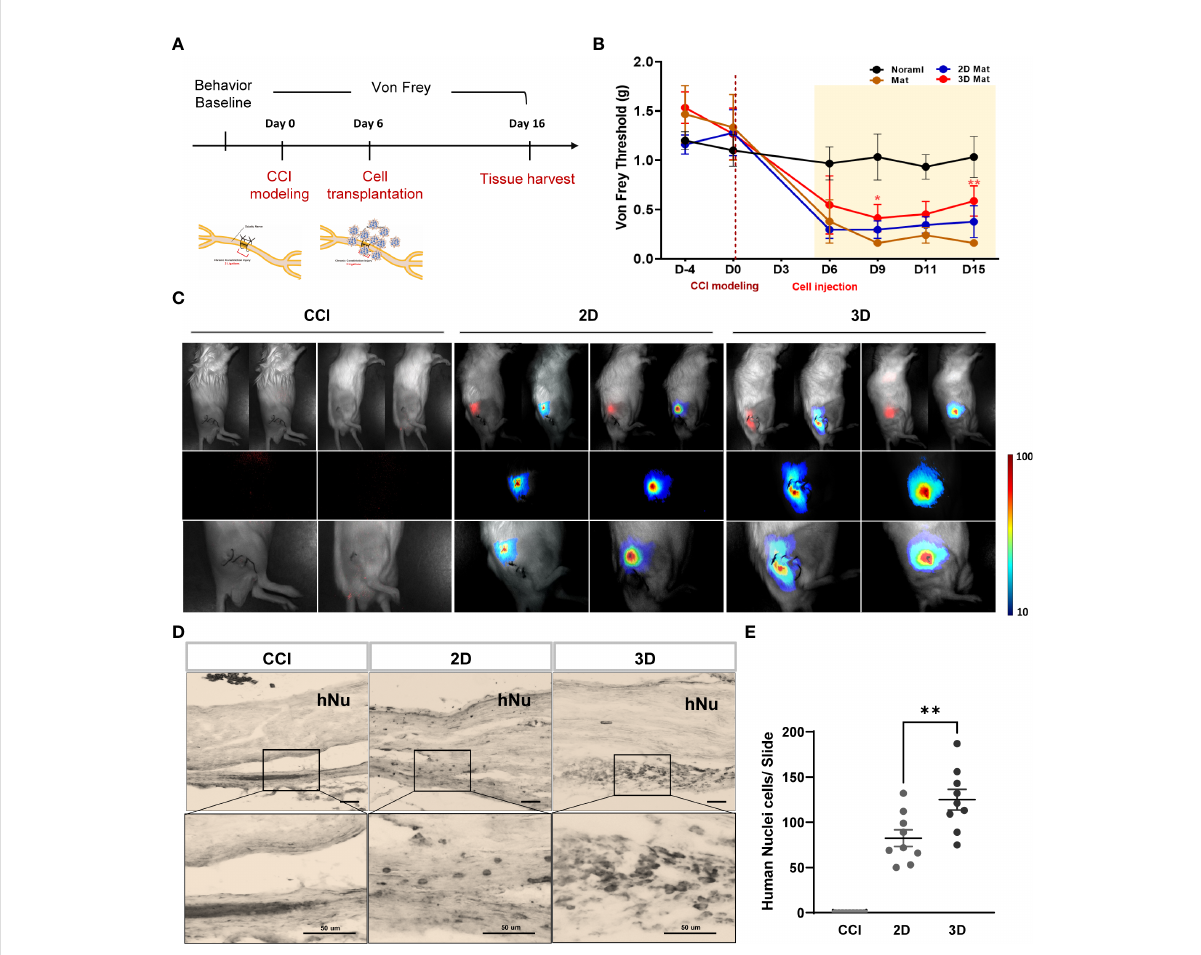
FIGURE 4 Von Frey test and grafted cell survival of MSC spheroids compared to monolayer cells. (A) Schematic overview of MSC spheroids and monolayer cell transplantation. All experimental groups are normal, vehicle, monolayer (2D MSC) and spheroid (3D MSC) (n = 6 mice for each group). Before CCI modeling (D-4), all groups were measured the baseline threshold of von Frey test. On day 6, vehicle and cell transplanted groups (1 X 10 6 cells/100ul for 2D and 100 spheroids/100ul for 3D) were transplanted into the injured hindlimb sciatic muscle region. All groups were performed the von Frey test every 3~4 days and sacri fi ced them on day 15. (B) Von Frey test of normal, vehicle, 2D MSC and 3D MSCs. (C) In vivo NIR-2 fl uorescence whole body imaging. The grafted cells are brightly labeled and detected on the injured sciatic nerve area. DAB immunohistochemistry staining (D) and number of positive cells (E) using an antibody against human nuclei (hNu) in the sciatic nerve. Scale bar: 50 m m. Von Frey threshold curves were statistically analyzed by two-way ANOVA. Data are presented as mean ± SEM, ** p < 0.01.